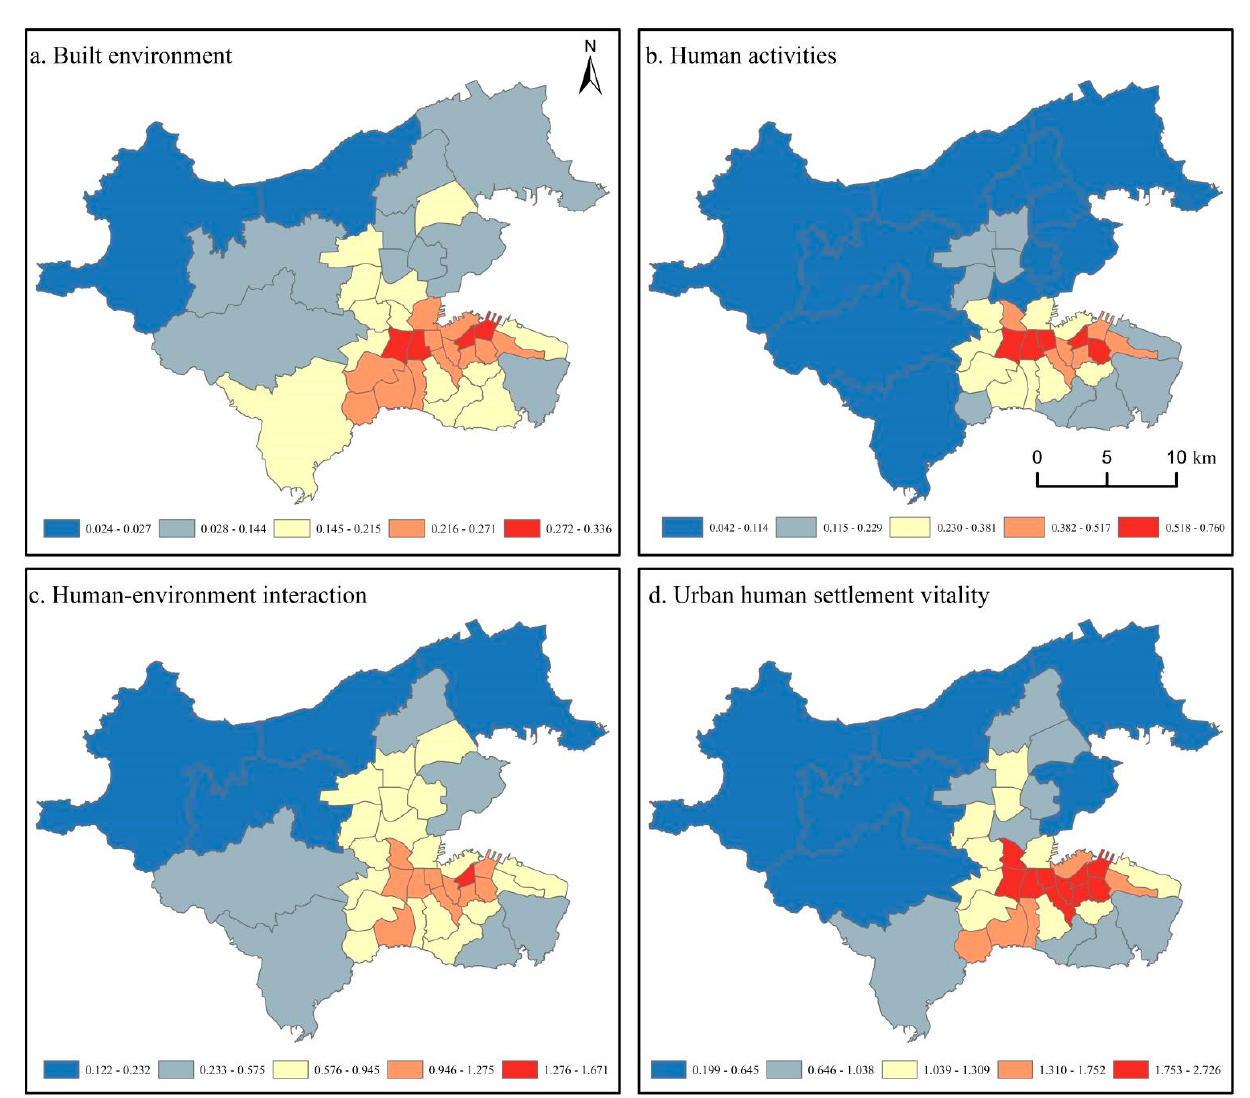
Figure 3. Spatial pattern of urban human settlements vitality.